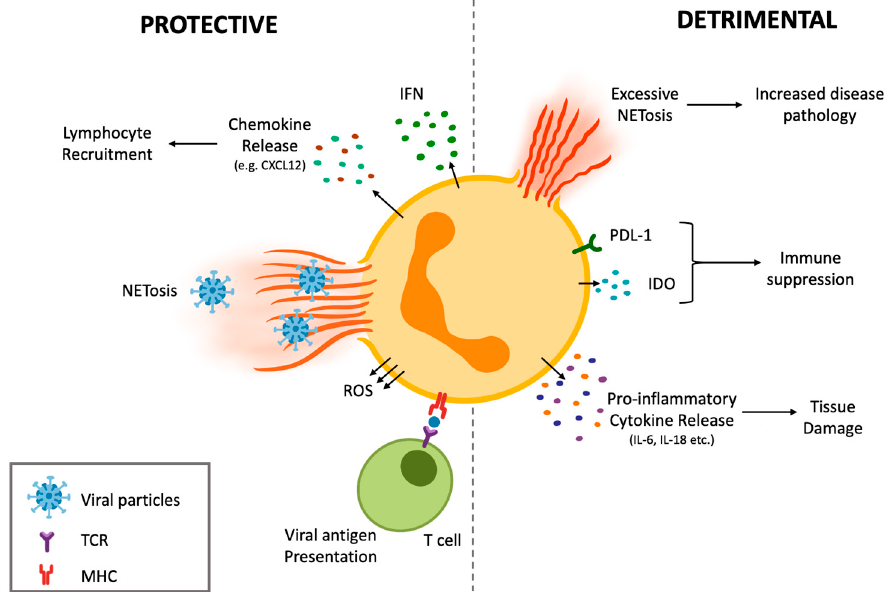
Figure 2. Neutrophils can be fine-tuned and influenced by their micro-environment to exert detrimental or protective immunological functions during anti-viral responses. Examples include recruitment of leukocytes through chemokine release and presentation of viral antigens to T cells. Additionally, neutrophils support type I interferon responses that mediate anti-viral immunity. However, neutrophils can also function in a manner that is harmful to the host. For example, neutrophils produce an array of pro-inflammatory cytokines, which when uncontrolled can lead to tissue damage. Similarly, when NETosis becomes dysregulated, there can be substantial bystander damage to tissues. Additionally, neutrophils have immunosuppressive capabilities that can hinder anti-viral responses, thereby reducing viral clearance.